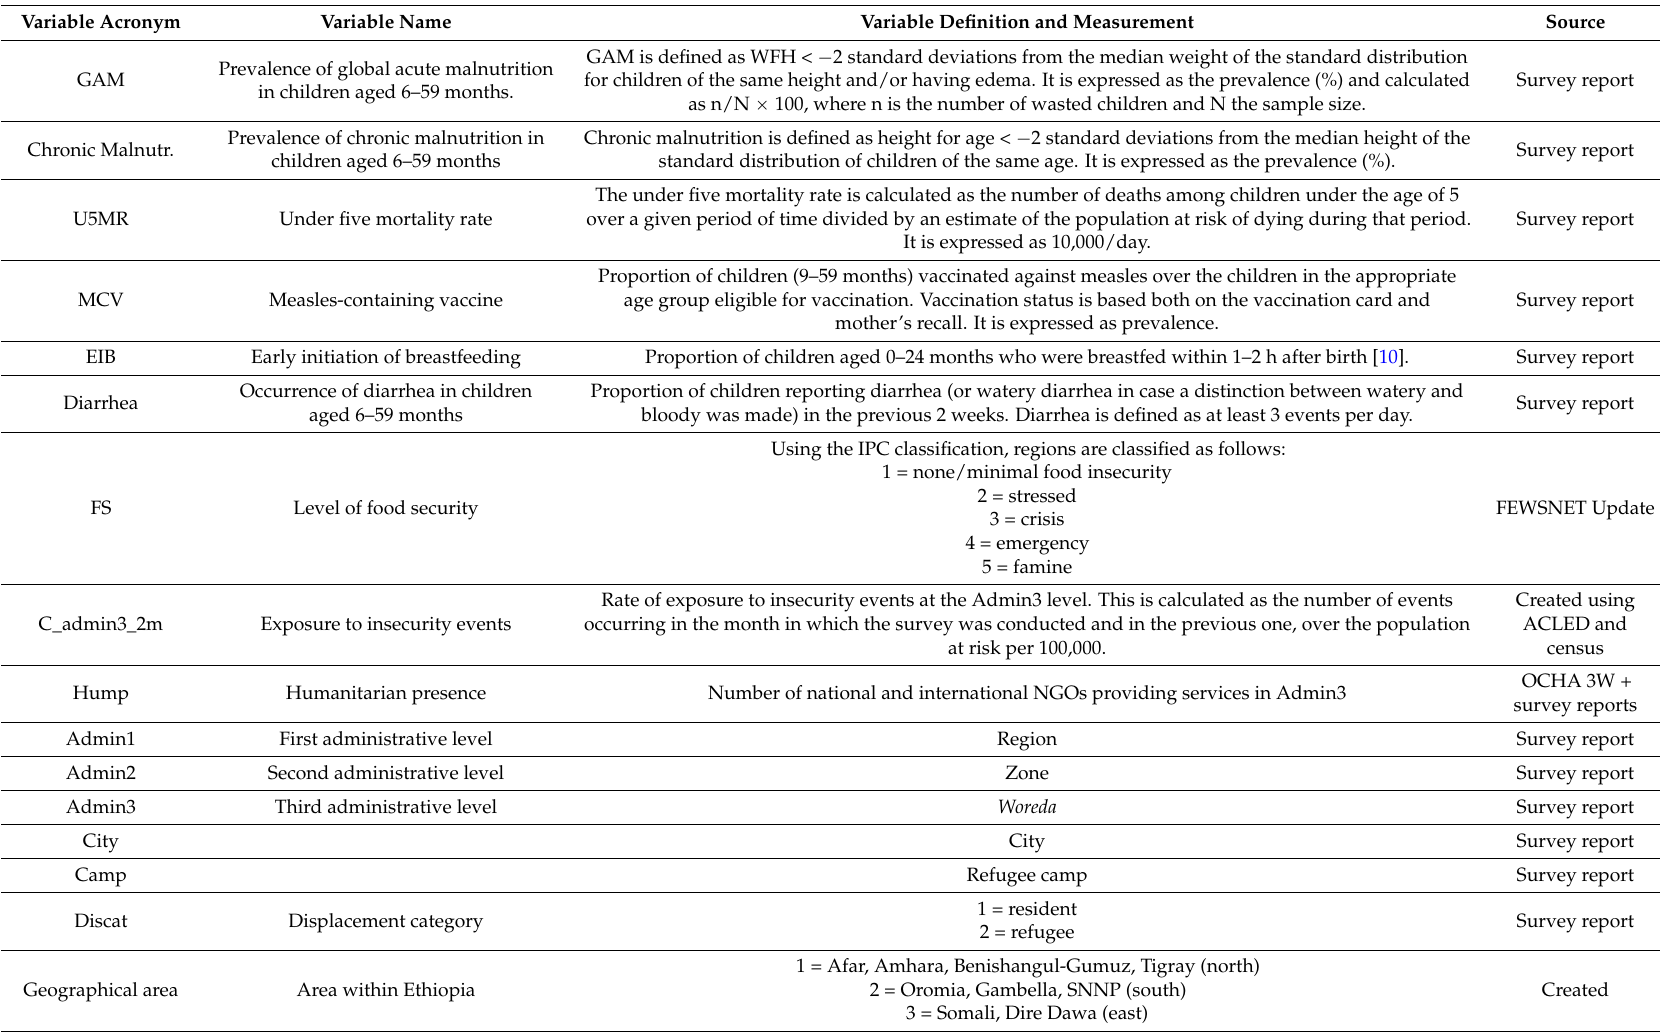
Table 1. Definition of variables used in the analysis. OCHA, Office for the Coordination of Humanitarian Affairs; 3W, “Who What